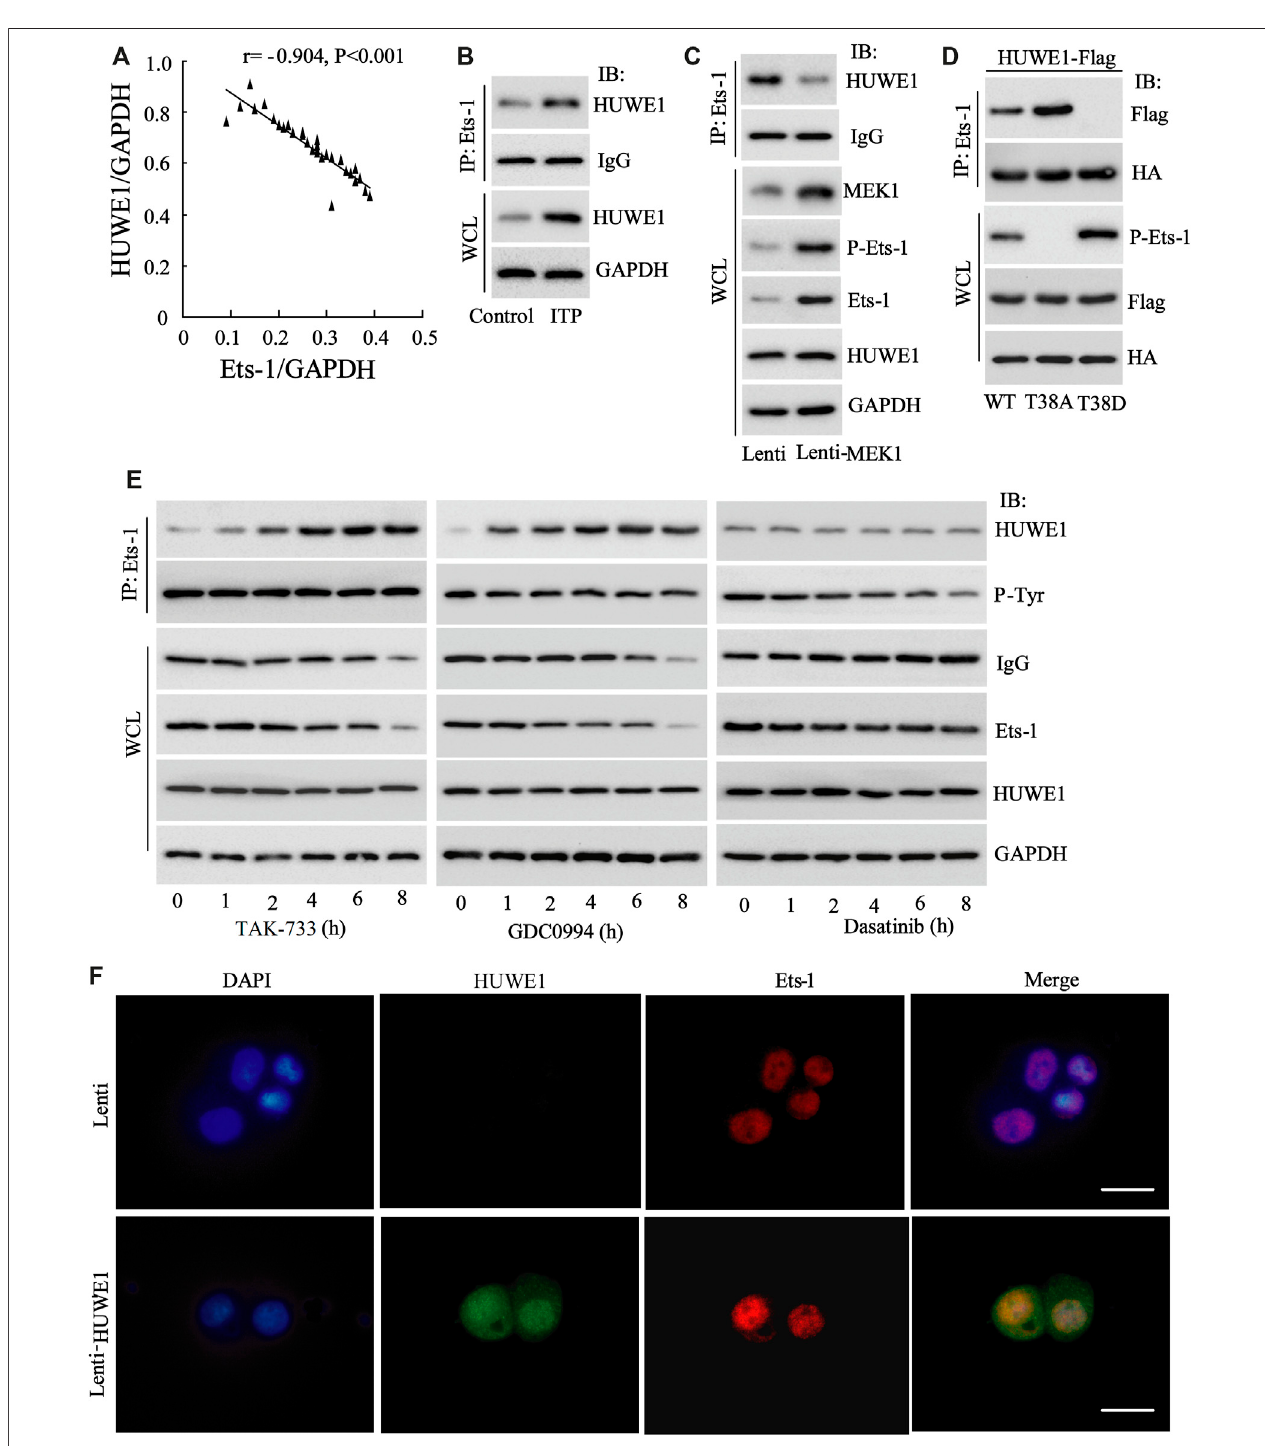
FIGURE4| TheinteractionbetweenHUWE1 and E26 transformation-speci fi c-1 (Ets-1). (A) Correlation analysisoftheprotein levelofHUWE1and theprotein level ofEts-1intheCD4 + Tcellsintheperipheralblood fromITPpatients ( r (cid:2) − 0.904, p < 0.001), n (cid:2) 30. (B) Immunoprecipitation (IP) wasperformedtoanalyzethebindingof HUWE1 to Ets-1 in CD4 + T cells in peripheral blood from healthy controls or ITP patients. (C) Lenti-MEK1 (a constitutively activated MEK1) was transfected into Jurkat T cells and the transfection ef fi ciency was veri fi ed by Western blot. IP was conducted to assess the binding of HUWE1 to Ets-1 and a Western bolt assay was applied to detect the protein levels ofp-Ets-1(T38 sites),Ets-1 and HUWE1. (D) 293Acells were transfected with WT (Ets-1 wild-type plasmid) and HUWE1-Flag,T38A (pointmutantplasmidphosphorylationinactivationatT38ofEts-1:mutatesTtoA)andHUWE1-Flag,orT38D(pointmutantplasmidphosphorylationactivationatT38of Ets-1: mutates T to D) and HUWE1-Flag for 24 h, HA for IP followed by Flag for immunoblotting (IB) or Flag for IP followed by HA for IB. The analysis of the binding of